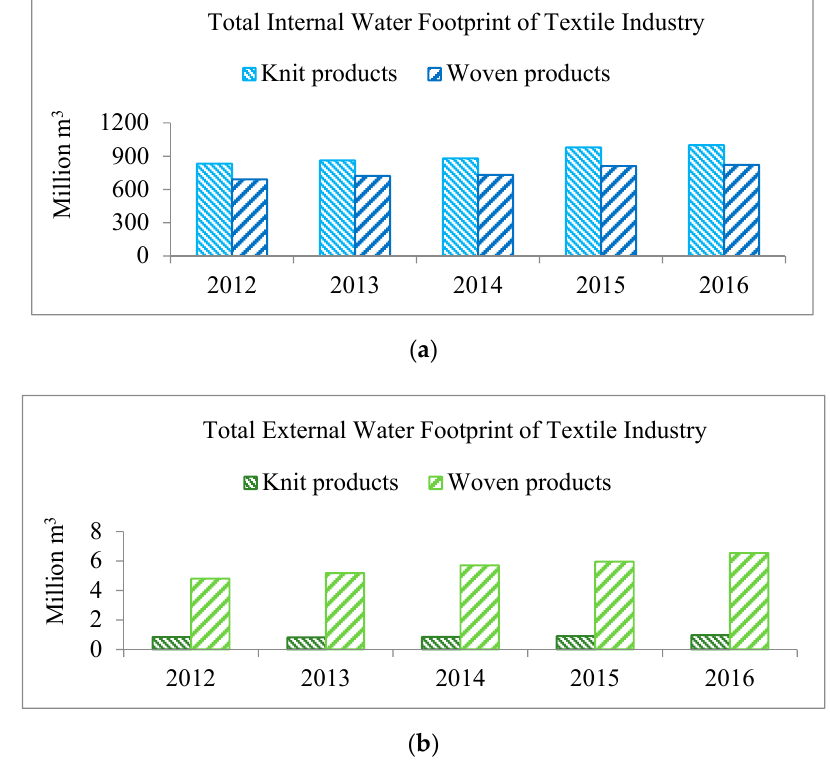
Figure 8. Total water footprint of textile industry ( a ) internal water footprint and ( b ) external water footprint.